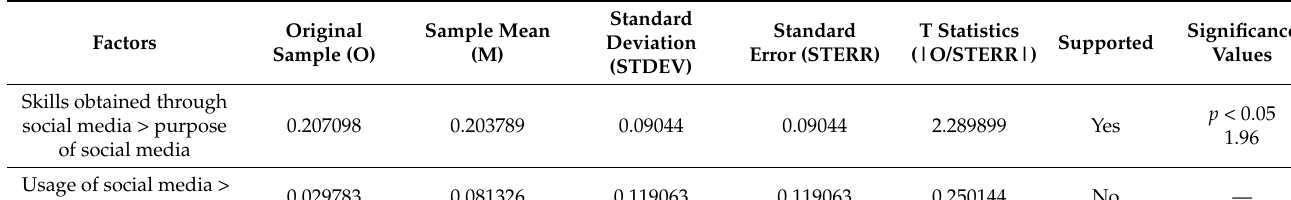
Table 6. Bootstrap values and T-values of path coefficients.